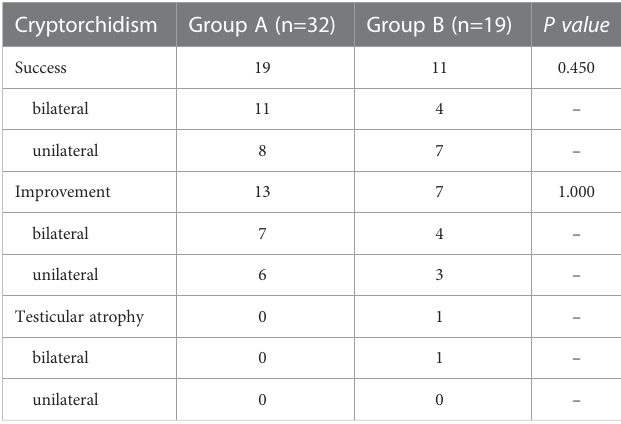
TABLE 2 The effect of hormonal therapy and surgery for cryptorchidism in IHH patients.